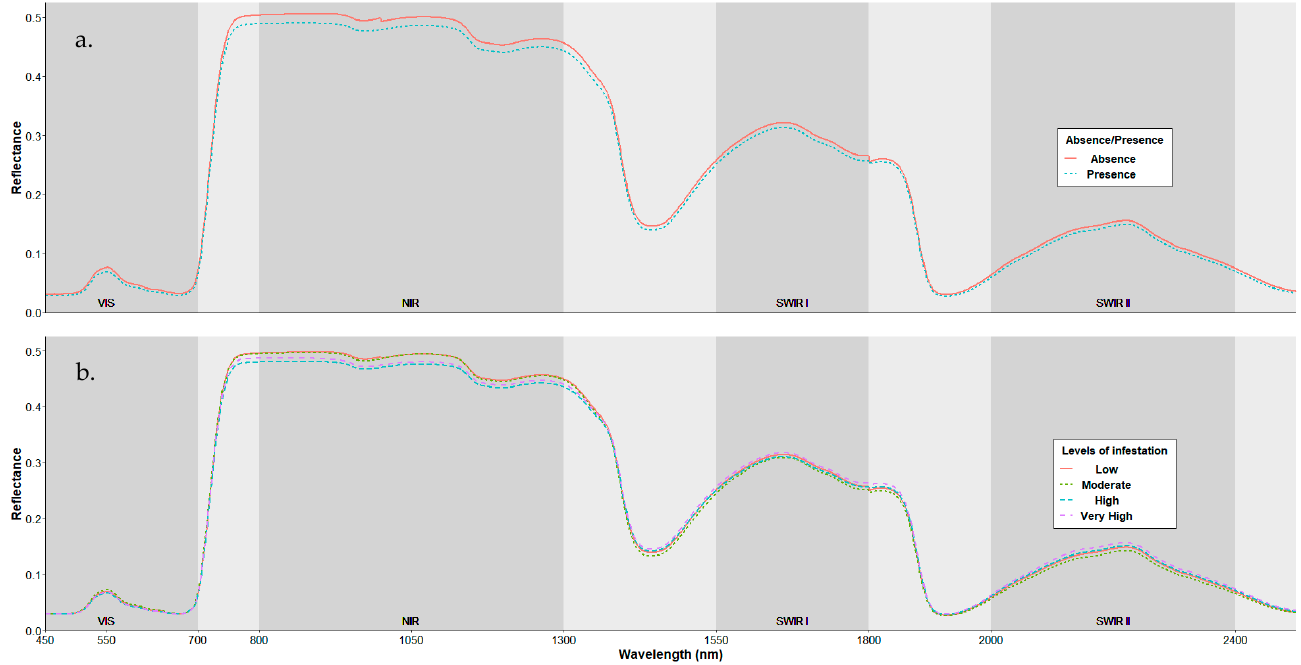
Figure 4. Spectral characterization using reflectance values, based on gall absence or presence (a) and on different infestation levels (b).